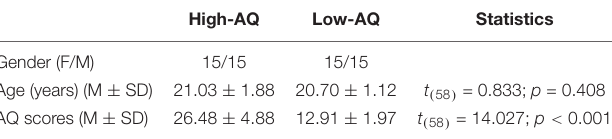
TABLE 1 | Demographic characteristics of the High-AQ and Low-AQ groups in Experiment